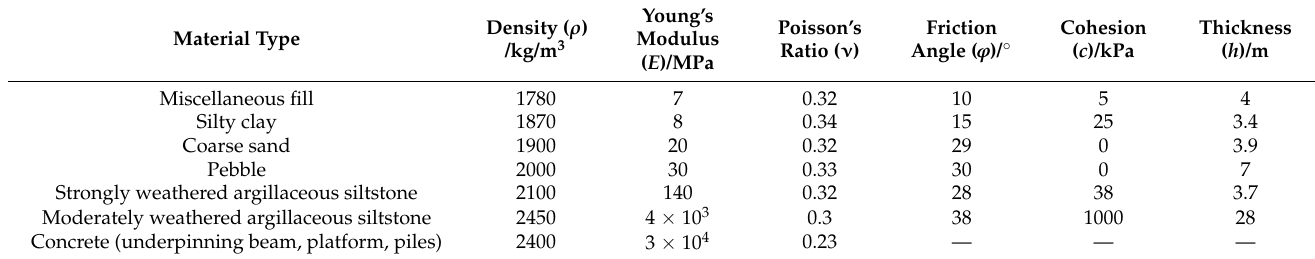
Table 2. Material parameters used in numerical modelling.